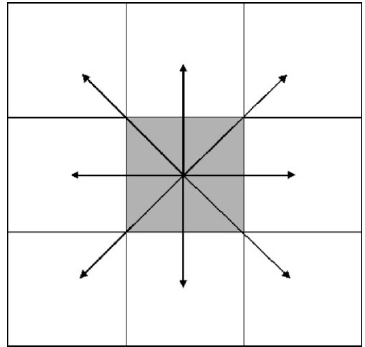
Figure 4. The eight possible fire spread directions on the square grid.